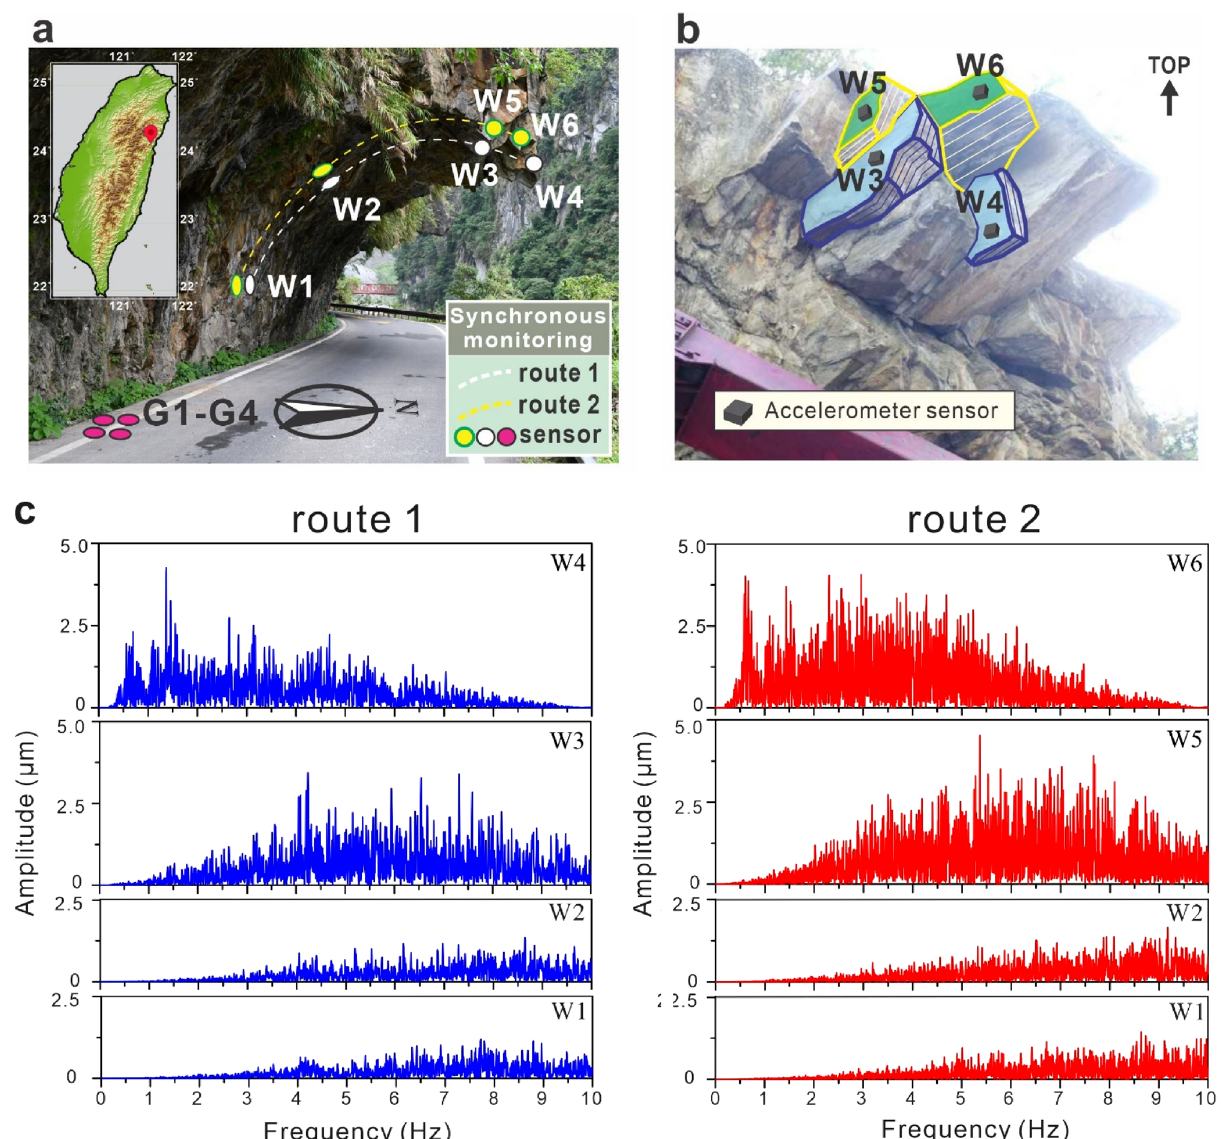
Figure 1. Microtremor monitoring of rock slope neighbouring mountain highways in central Taiwan. ( a ) Site photograph of the field experiment on the overhanging slope along the old Tai-8 highway and locations of the measurement points. Overview map showing the study region within Taiwan. ( b ) Photograph of the overhanging rock wedges monitored by the accelerometer sensors on the slope. ( c ) Fast Fourier transform results of the microtremor signals in the vertical direction of measurement points on route 1 (left) and on route 2